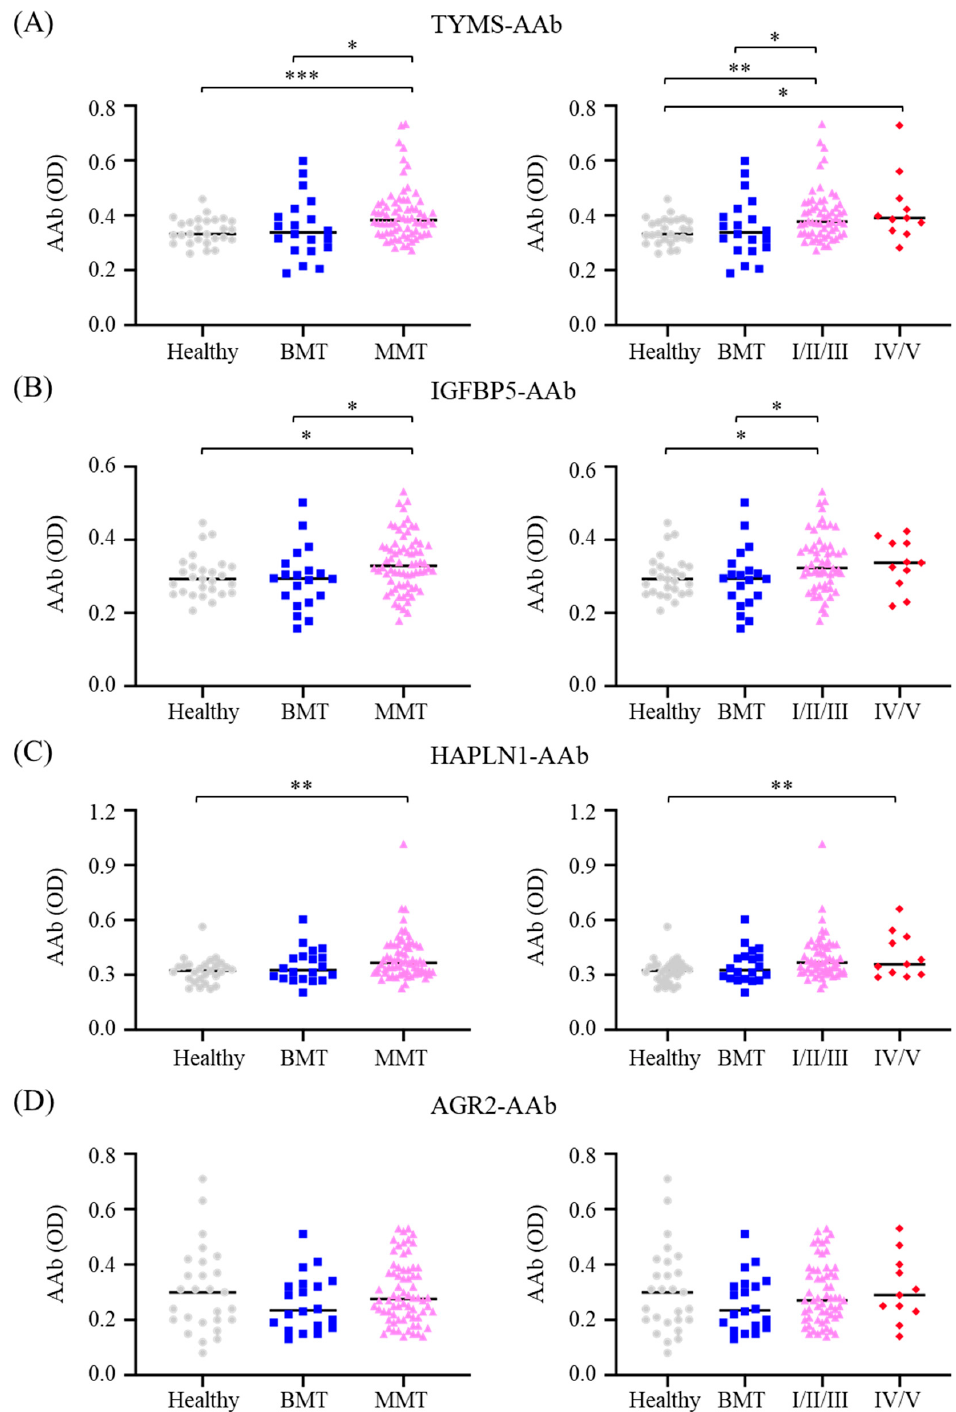
Figure 1. Comparison of serum levels of CMT-associated autoantibodies (AAbs) between CMT dogs and healthy controls. Serum levels of ( A ) TYMS-AAb, ( B ) IGFBP5-AAb, ( C ) HAPLN1-AAb, and ( D ) AGR2-AAb in dogs with malignant CMT (denoted MMT; left panels), which comprised the non-metastatic group (stage I, II, and III; denoted I/II/III; right panels) and the metastatic group (stage IV and V; denoted IV/V; right panels), were compared with those in the group of benign CMT (denoted BMT) or healthy controls. Results are presented in scatter dot plots, wherein each dot represents the serum AAb level in individual patients. The bar shown is the median. Statistical analysis was conducted with the Mann–Whitney U test. * p < 0.05; ** p < 0.01; *** p <